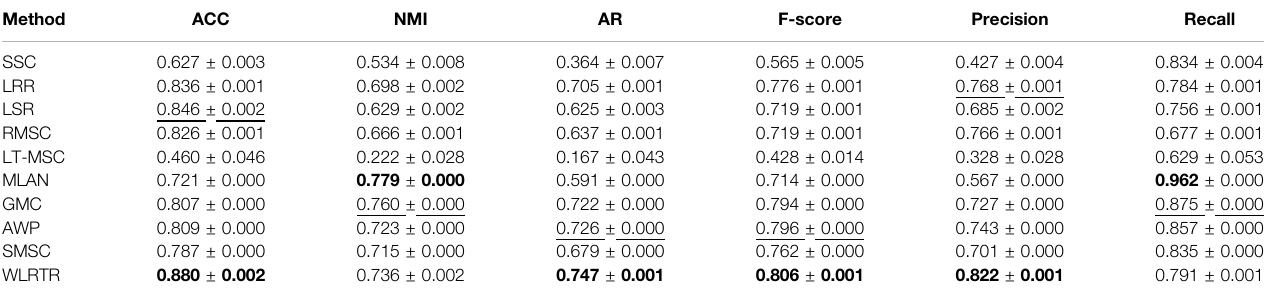
TABLE 5 | Clustering results on BBCSport database.